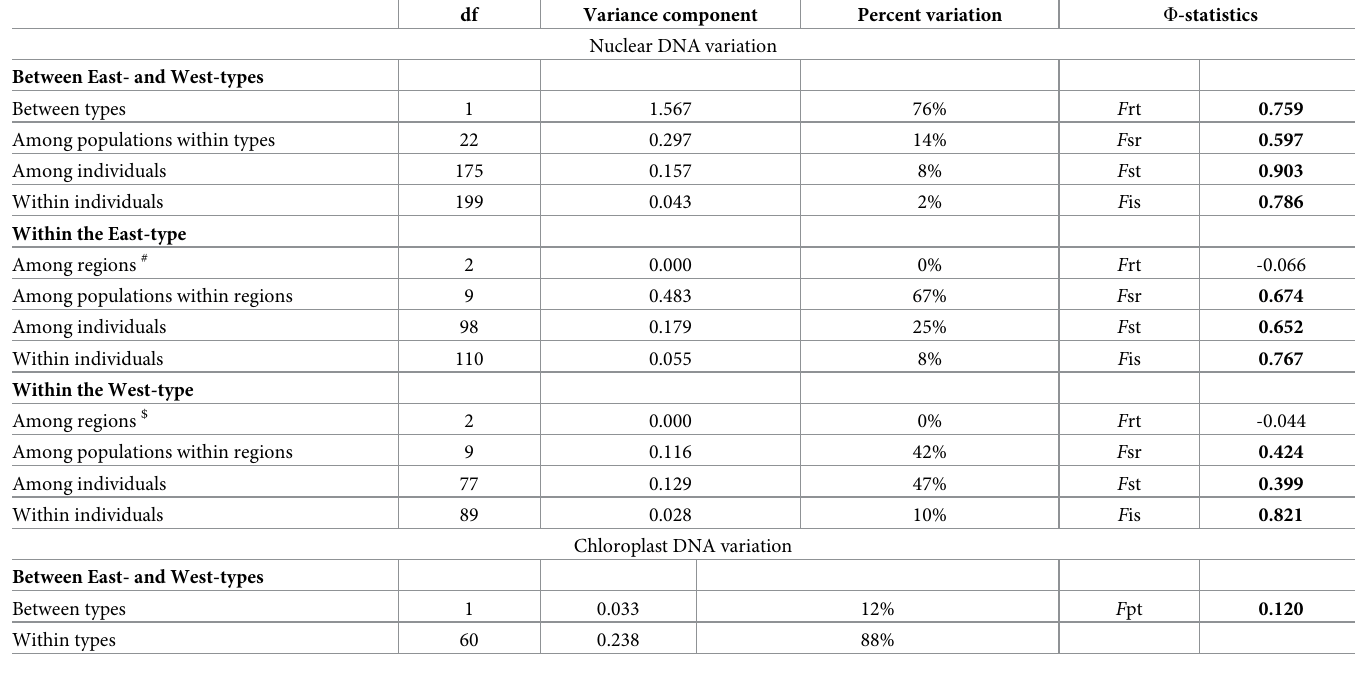
Table 5. AMOVA results comparing the genetic variation between the East- and West-types and among regions for Lepisorus nigripes .